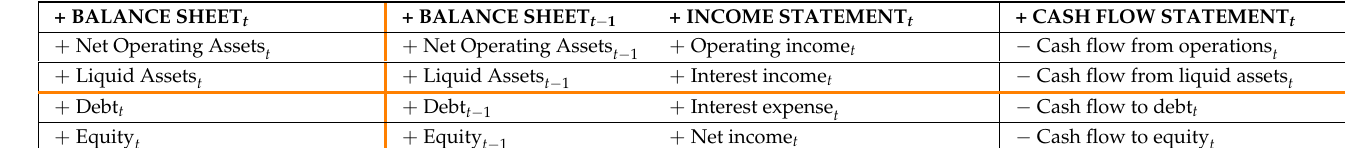
Table 1. The Split-Screen Matrix (SSM).